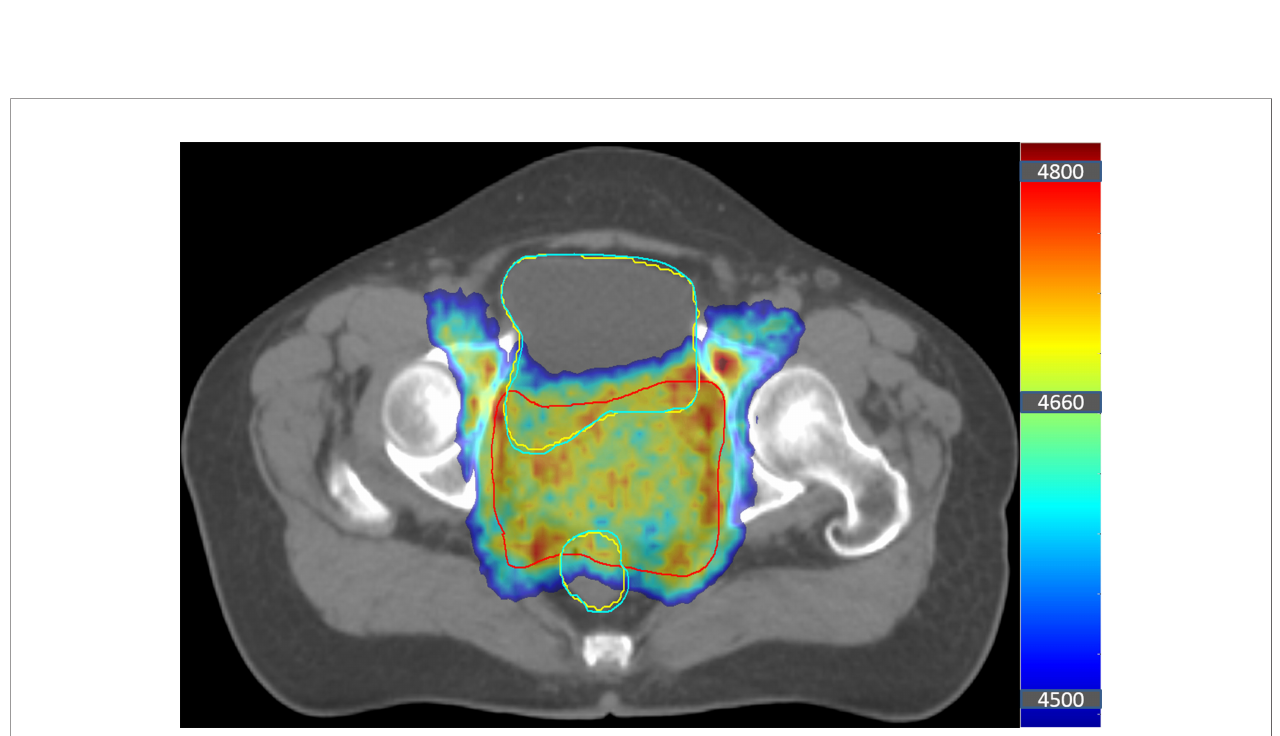
FIGURE 6 | Diagram showing the position of the target volume, the bladder, and the rectum in a patient with cervical cancer. The coloured area denotes the target volume receiving > 45 Gy. The area marked with the red solid line is the clinical target volume (CTV), the blue solid lines denote the manually segmented contours, and the yellow solid lines denote the auto-segmented contours.